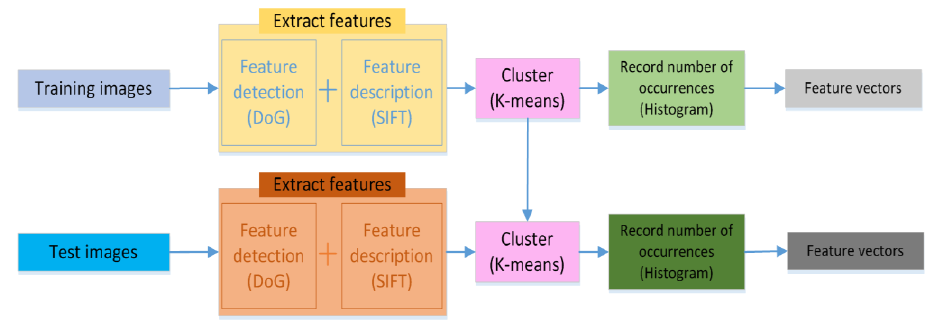
Figure 11. BOW structure.